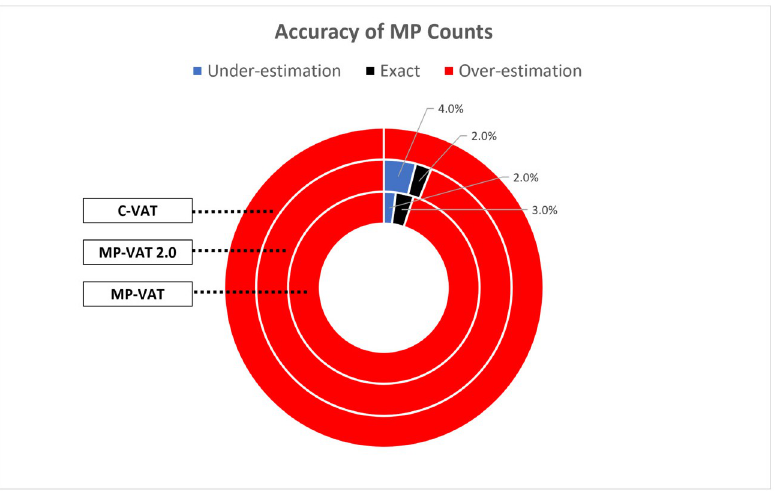
Fig 8. Accuracy of MP counts by MP-VAT, MP-VAT 2.0, and C-VAT. Predictions of MP quantity that are less than, equal to, and more than that of the ground truth are denoted as under-estimation, exact, and over-estimation, respectively. At least 94% of the predicted values from C-VAT, MP-VAT, and MP-VAT 2.0 were